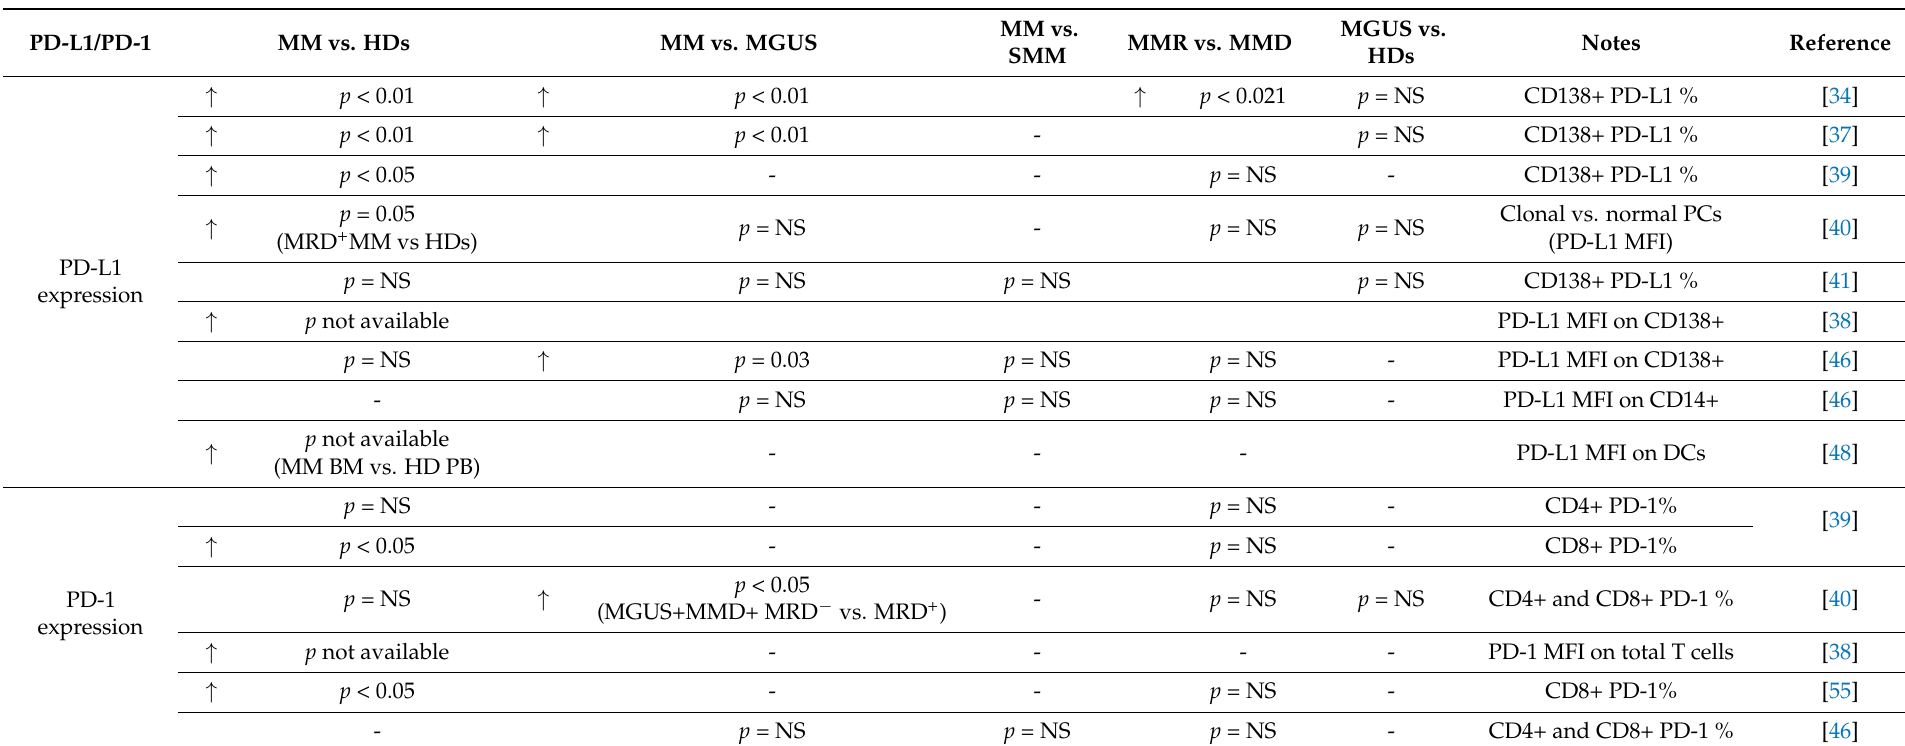
Table 1. Summary of programmed death-ligand 1/programmed cell death-1 (PD-L1/PD-1) distribution in patients with pre-malignant monoclonal gammopathies and MM at different stages of